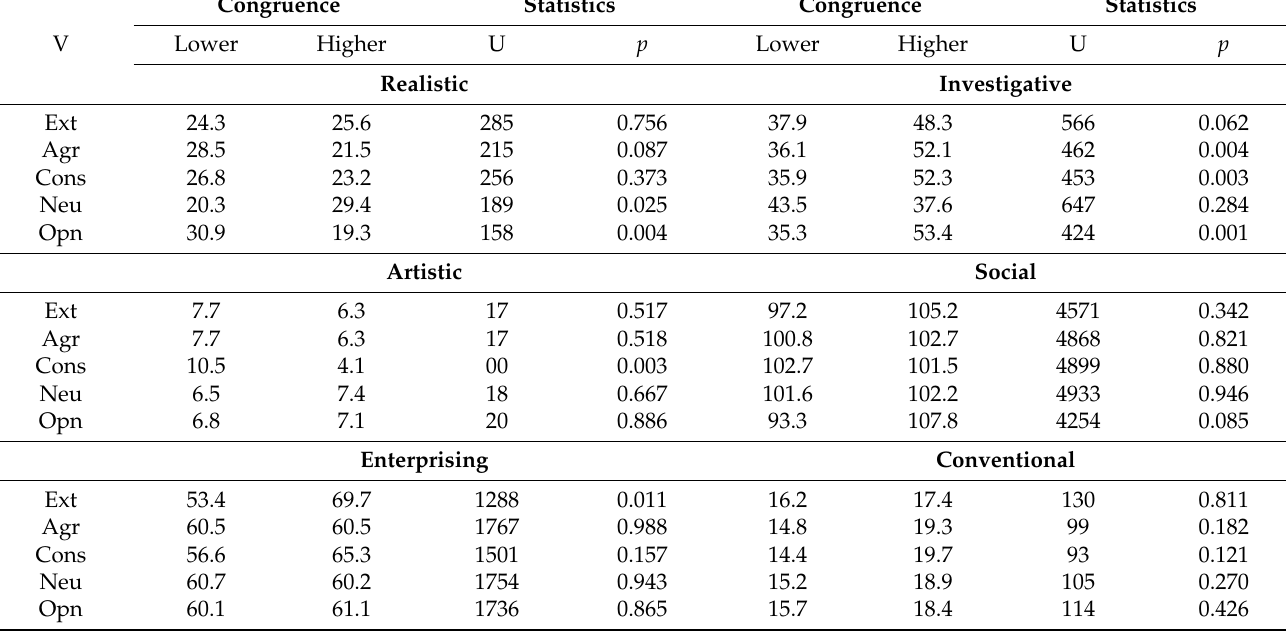
Table 4. Test for comparing ranks between groups of higher and lower